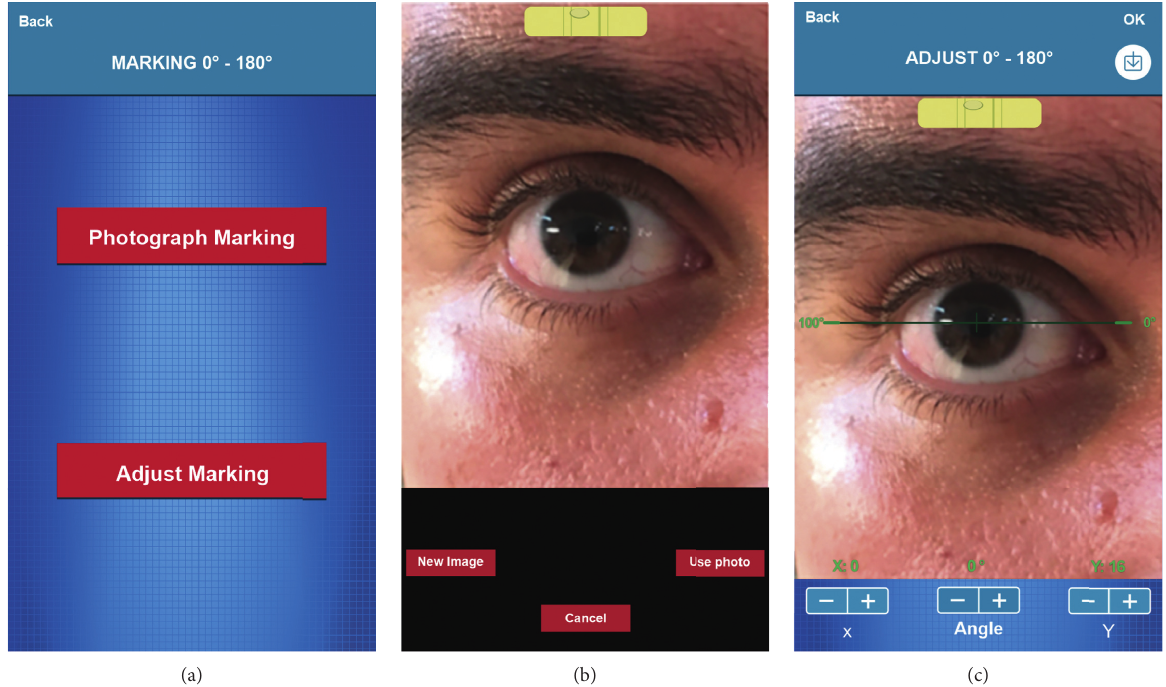
Figure 1: (a) “Marking 0 ° –180 ° ,” (b) “Photograph Marking,” and (c) “Adjust Marking” screens from the app. It is possible to verify whether there is any tilt from the 0 ° –180 ° marking and to adjust if